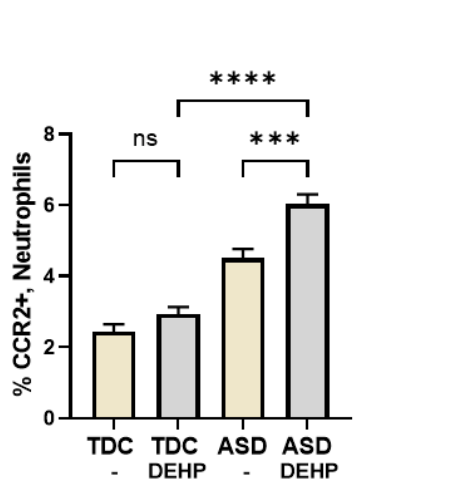
Figure 4. E ff ect of DEHP on CCR2 and MCP-1 expression in neutrophils of ASD and TDC subjects. ( A ) Percentage of CCR2 expression in neutrophils and ( B ) percentage of MCP-1 expression in neu- trophils. Values are presented as mean ± SEM, n = 15/group. ** p < 0.01; *** p < 0.001; **** p < 0.0001; ns= not signi fi cant.